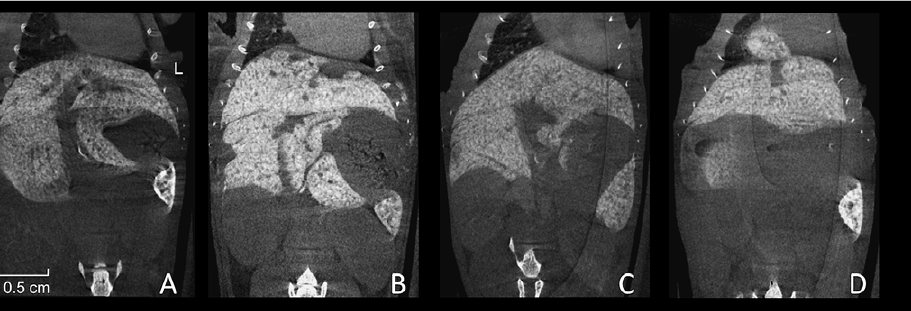
Figure 5. Liver variationes. A–C are comparable coronal sections of the murine liver illustrating the variability of the size of the papillary process of the caudate lobe. D shows transdiaphragmatic herniation of parts of the right medial liver lobe, which we incidentally discovered during our studies.